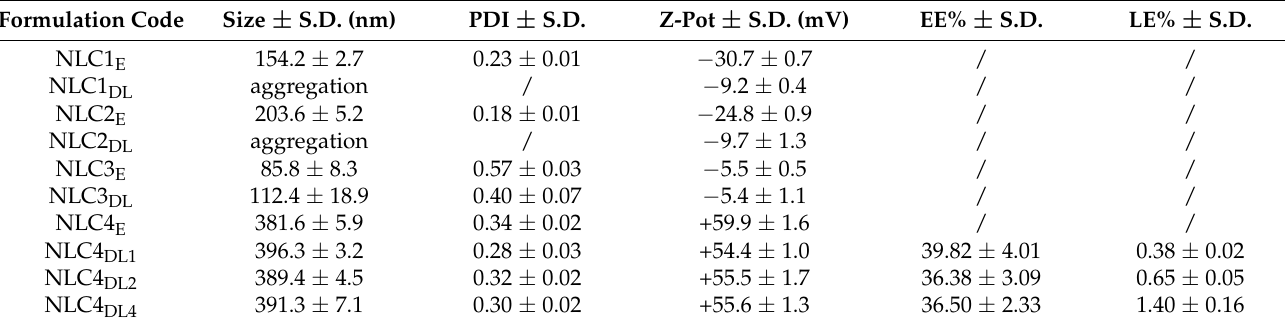
Table 3. Physicochemical properties of NLCs in terms of mean size, polydispersity index (PDI), and Zeta potential (Z-pot). Encapsulation efficiency (EE%) and loading efficiency (LE%) of the selected formulations are also reported (see Table 1 for NLC